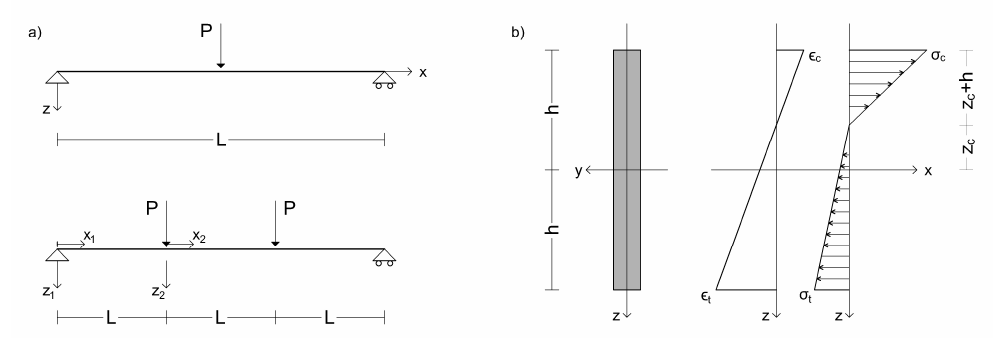
Figure 1. Scheme of the beam under three and four-point bending assuming a bi-modulus mate- rial ( E c > E t ): ( a ) reference systems, dimensions and load cases, ( b ) beam cross-section showing asymmetrical strains and stress through the